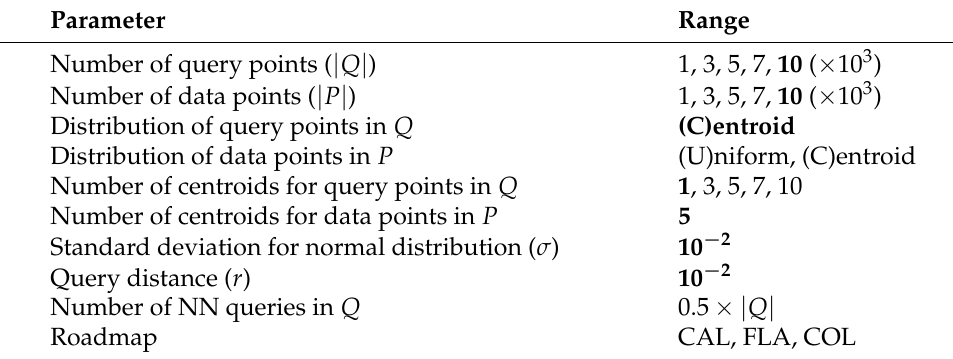
Table 6. Experimental parameter